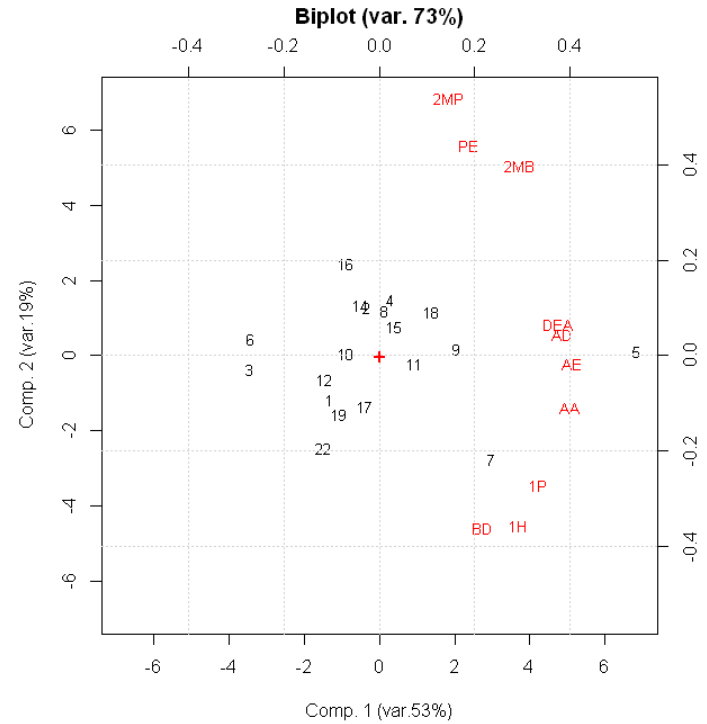
Figure 5. Biplot for PCA analysis (19 Filuferru samples, 10 analytical variables). Sample origin: 1, Galtellì; 2, Atzara; 3, Orgosolo; 4, 5, 7, 10, 12, 18 and 19, Orotelli; 6, 9, Silanus; 8, 14, Sarule; 11, Arzana; 15, 17, Fonni; 22, commercial Filuferru . Acronyms of volatile compounds; DEA, dietyl acetal; AD, acetaldehyde; AE, ethyl acetate; AA, acetic acid; 1P, 1-propanol; 2MP, 2-methyl-1-propanol; 2MB, the sum of 2-methyl-1-butanol and 3-methyl-1-butanol; 1H, 1-hexanol; PE, 2-phenylethanol; BD, 2,3- butanediol.